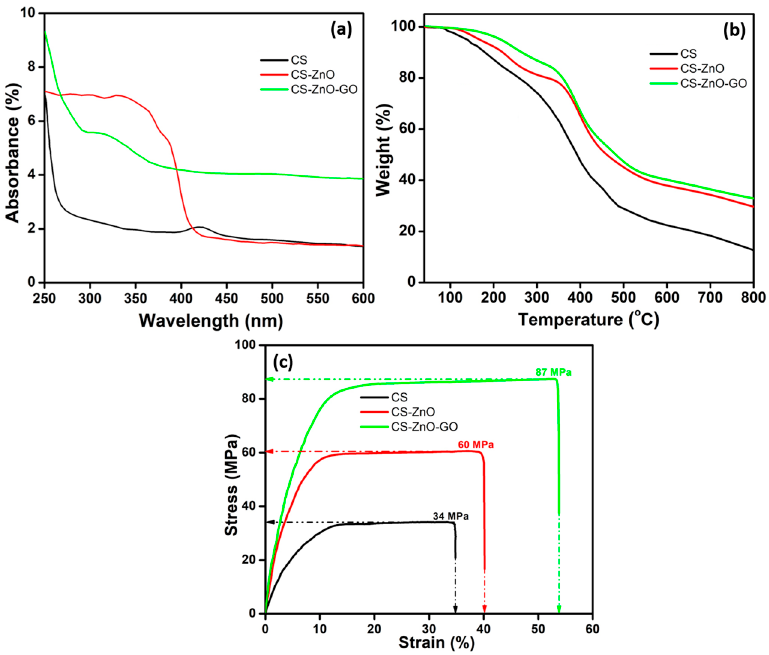
Figure 3 . ( a ) UV–Vis spectra; ( b ) thermogravimetric (TGA) curves; and ( c ) mechanical properties of CS and the CS–ZnO and CS–ZnO–GO hybrid structures.